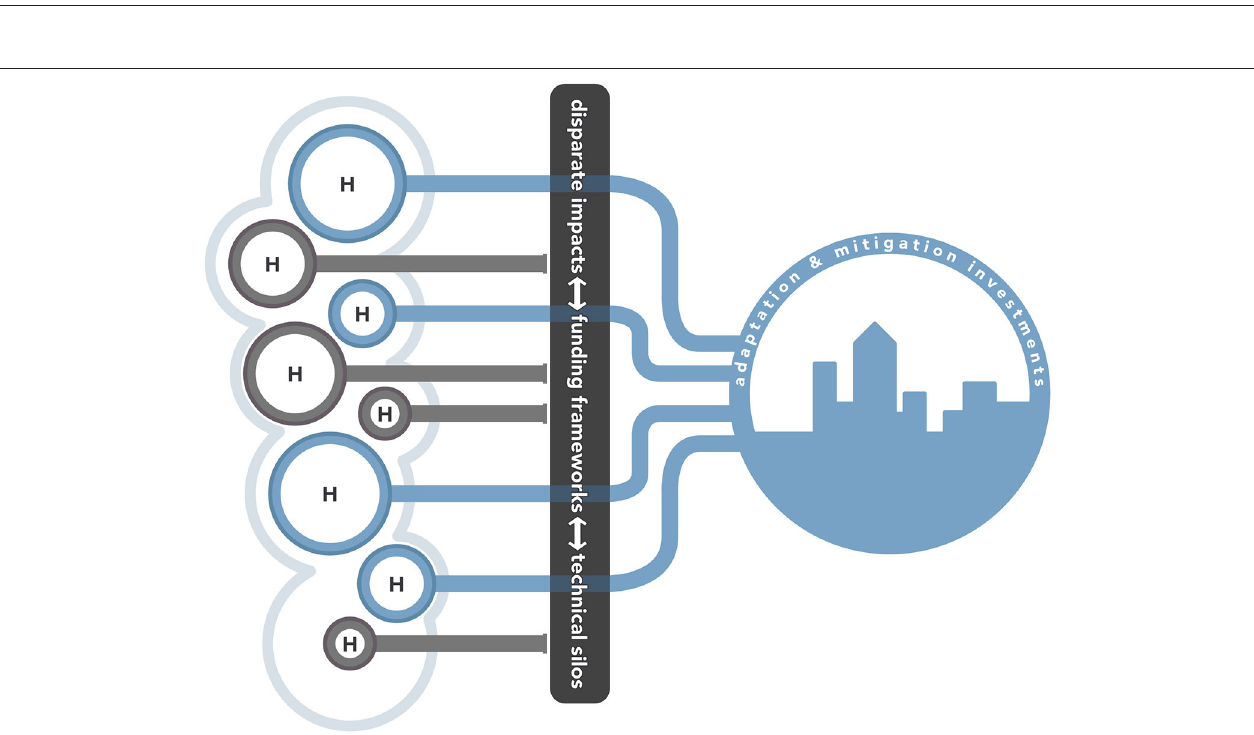
Frontiers in Climate |